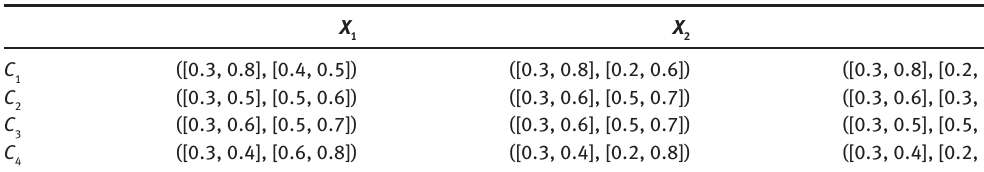
Table 9: Pythagorean Fuzzy Ordered Decision Matrix R 2 .